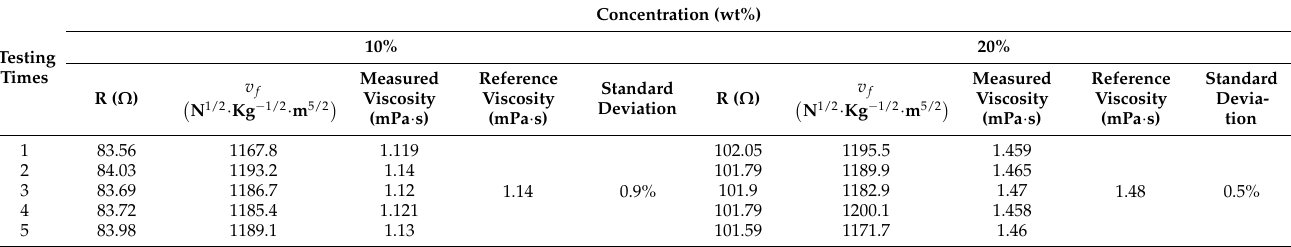
Table 4. Measured the blood viscosity by impedance analysis method.